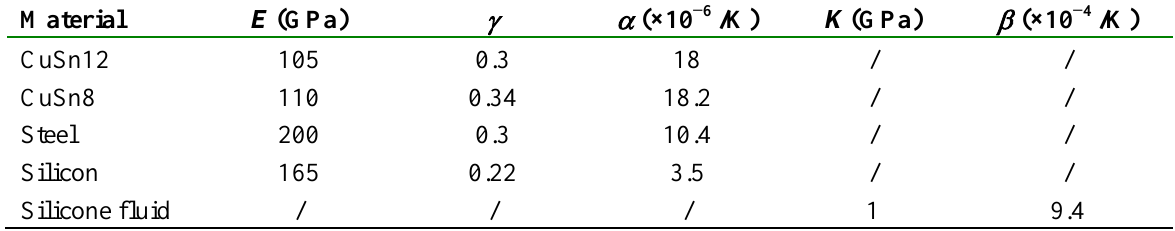
Table 1. Material data used in the simulations of the hydraulic load